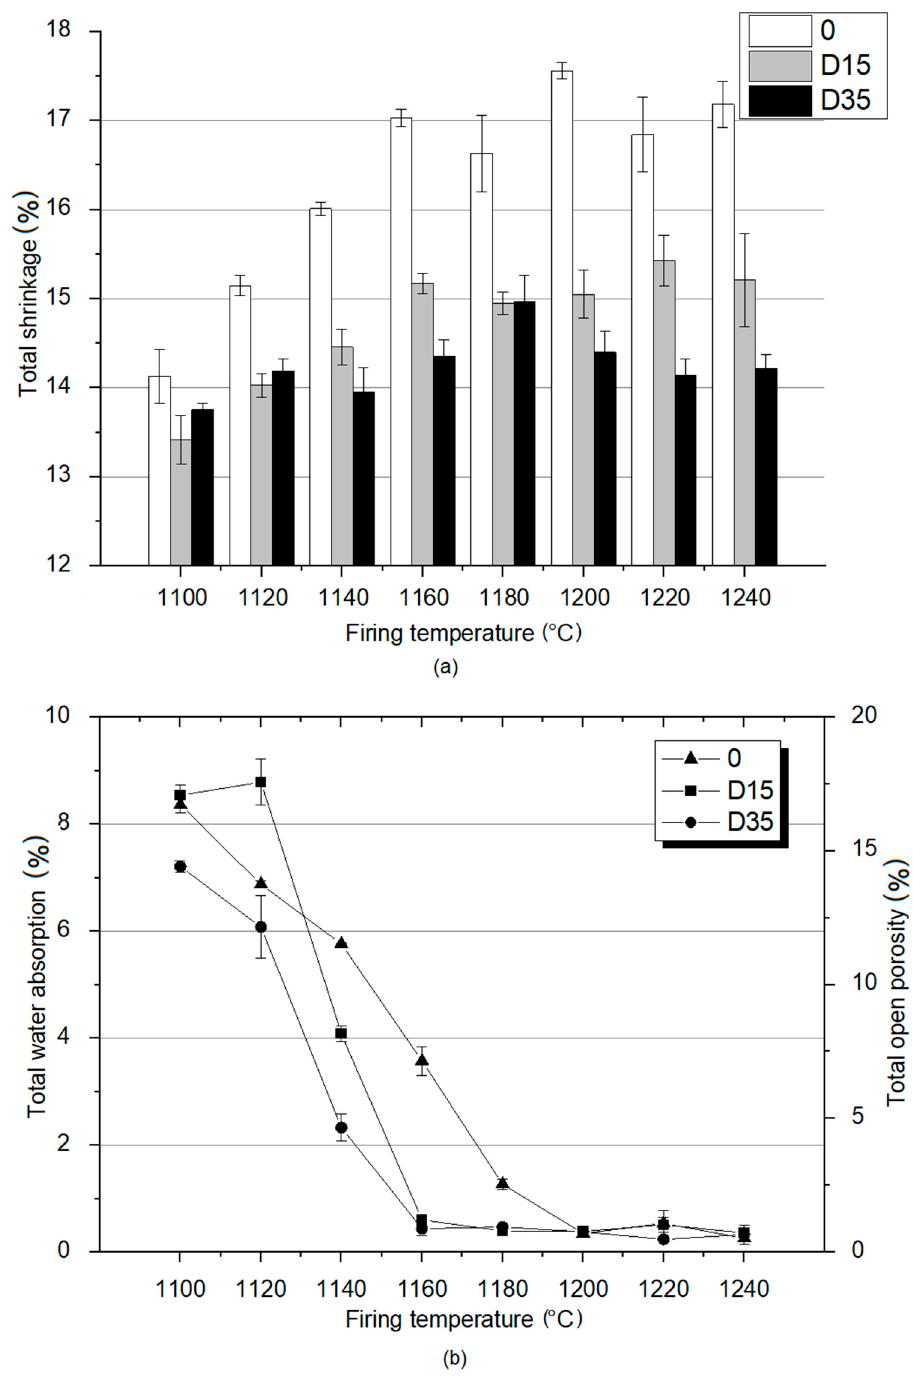
Figure 5. Material properties analysis of obtained ceramic materials: ( a ) total shrinkage; ( b ) total water absorption and total open porosity.